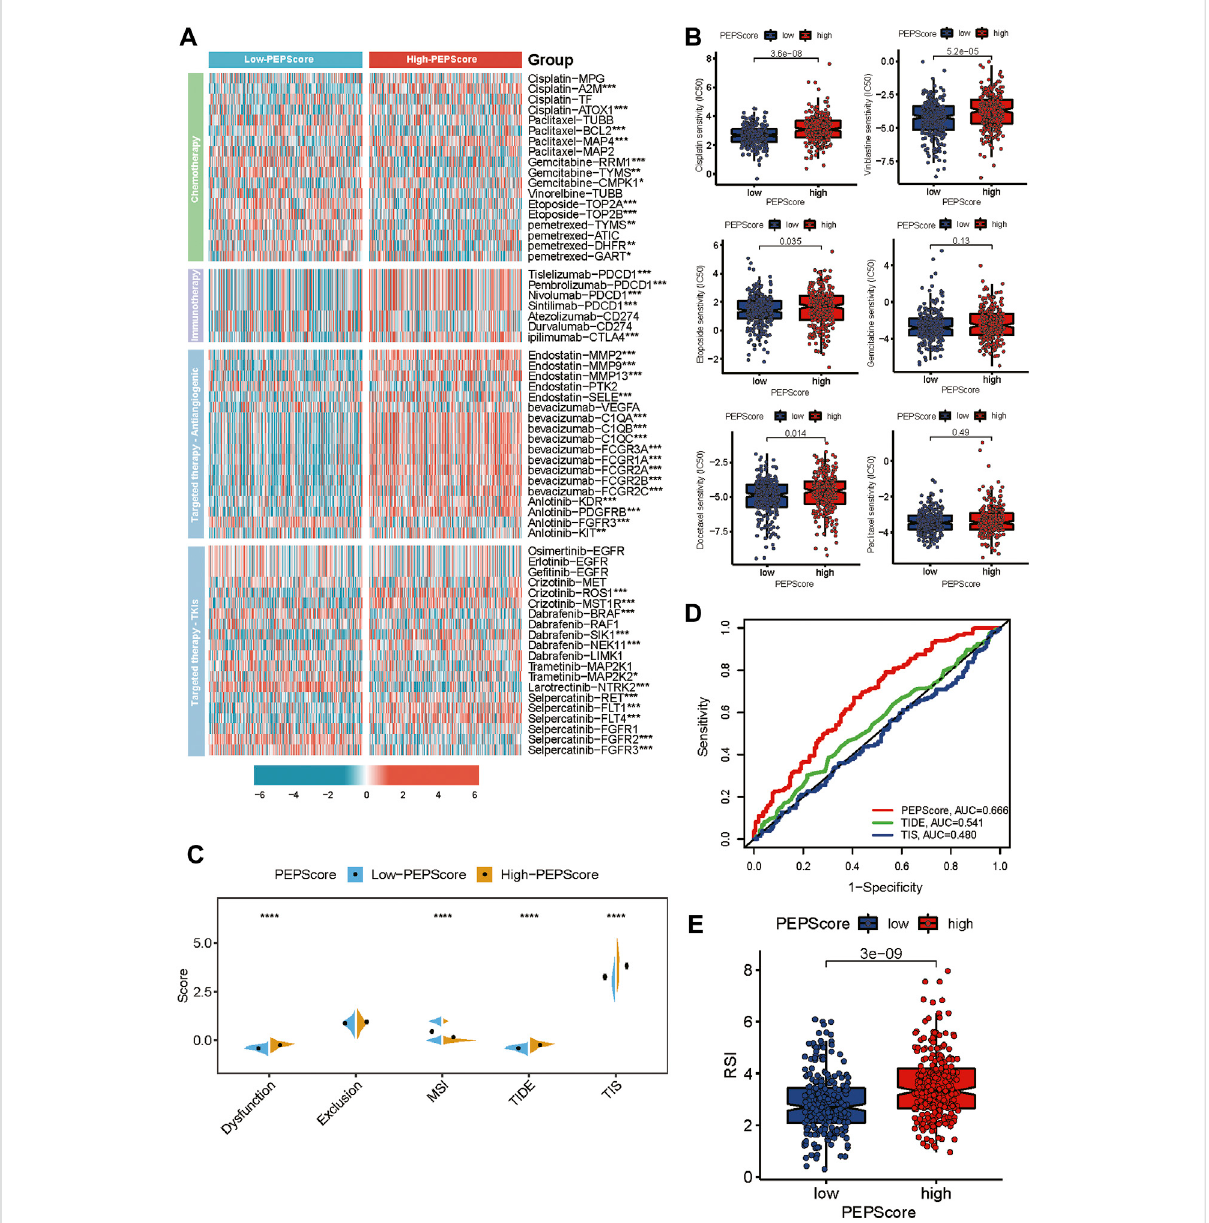
FIGURE 6 PEPScore predicts drug sensitivity. (A) The heatmap presents the different expressions of common drug targets for LUSC patients in high- PEPScore and low-PEPScore subgroups. Asterisk denotes the p -value (*: p < 0.05, **: p < 0.01, and ***: p < 0.001). (B) The difference in IC50 of the common chemotherapeutic drugs between high- and low-PEPScore subgroups. (C) The Wilcoxon test shows the difference in TIDE, MSI, TIS and T cell exclusion and dysfunction scores in high- and low-PEPScore subgroups. The p -value is indicated by asterisk (**** p < 0.0001). (D) ROC curve analysis of thepredictivevalueof the PEPScore, TIDE and TIS. (E) The difference in Radiotherapy index (RSI)betweenhigh- and low-PEPScore